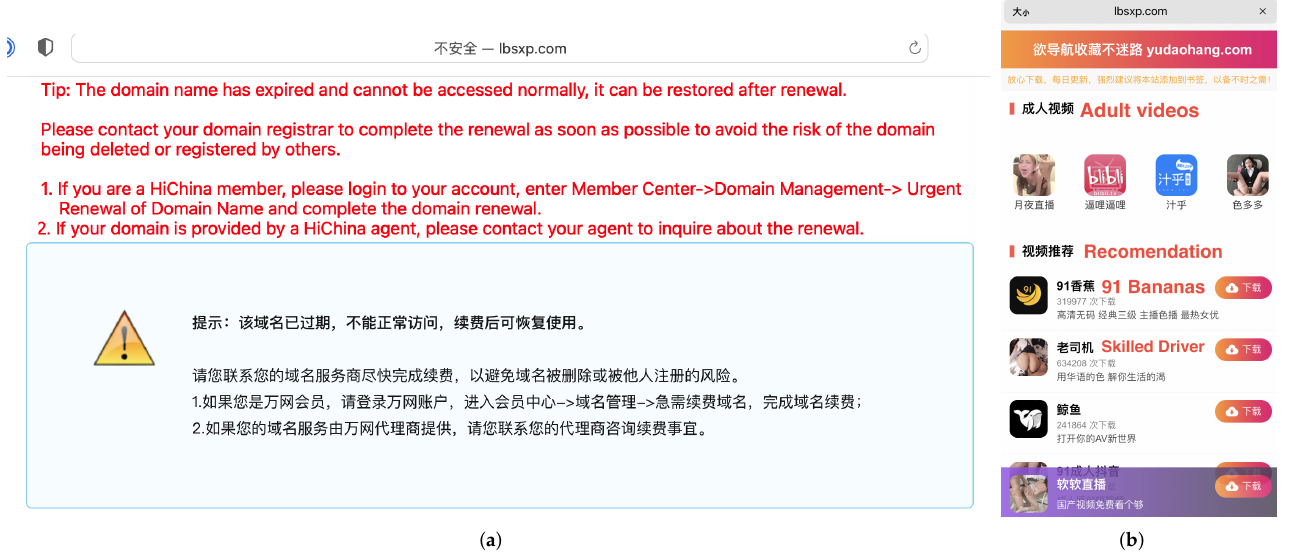
Figure 15. Using browsers of different platforms to access the same abusive domain name. ( a ) MacBook Safari. ( b ) iPhone